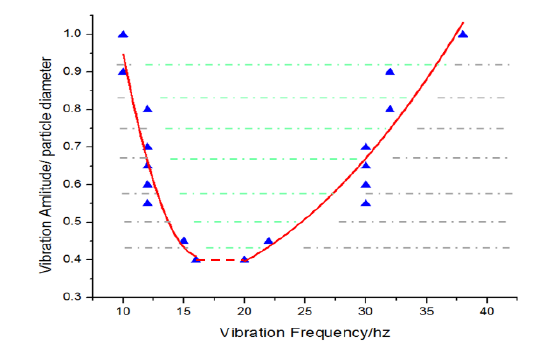
Fig. 1. Phase diagram of BNE versus vibration parameters. The grey dash-dot area represents the conditions where BNE cannot occur while the green dash-dot area represents the conditions where BNE can be observed. The particles used: 20 mm for large spheres and 10 mm for small spheres.